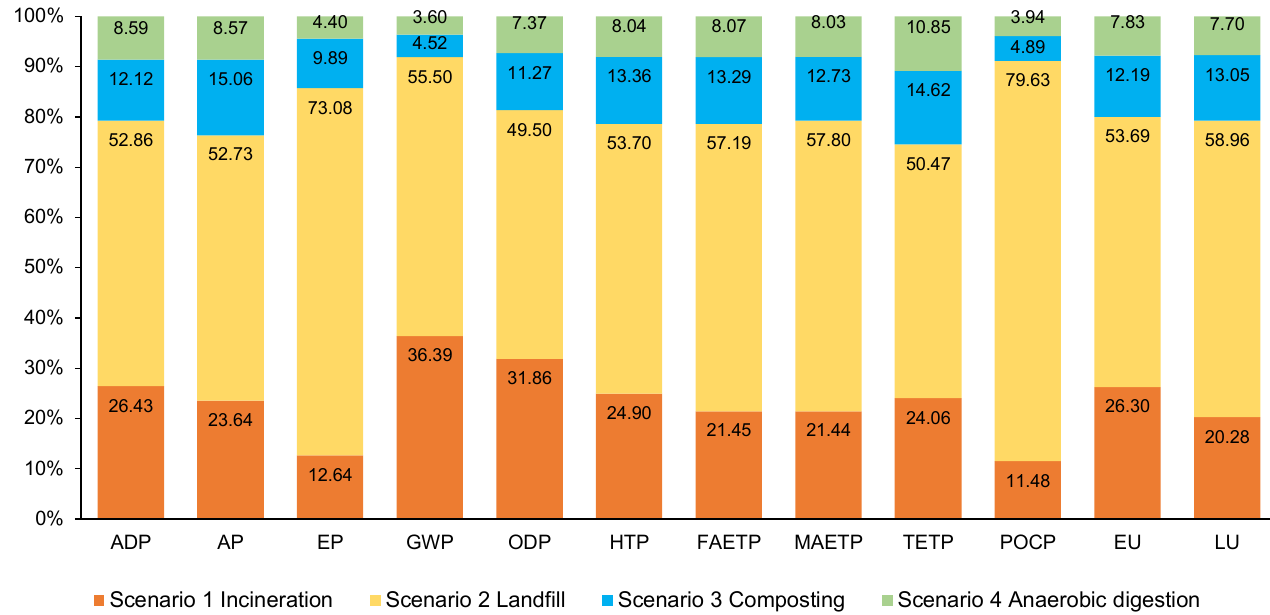
Figure 2. Characterization results of the four scenarios: percentage contributions to the potential environmental impacts for each characterization factors by each scenario (without the inclusion of the avoided products, AvPr). The characterization factors are: Abiotic Depletion (ADP), Acidification (AP), Eutrophication (EP), Global Warming (GWP), Ozone Layer Depletion (ODP), Human Toxicity (HTP), Fresh Water Aquatic Ecotoxicity (FAETP), Marine Aquatic Ecotoxicity (MAETP), Terrestrial Ecotoxicity (TETP), Photochemical Oxidation (POCP), Energy use (EU), and Land use (LU).